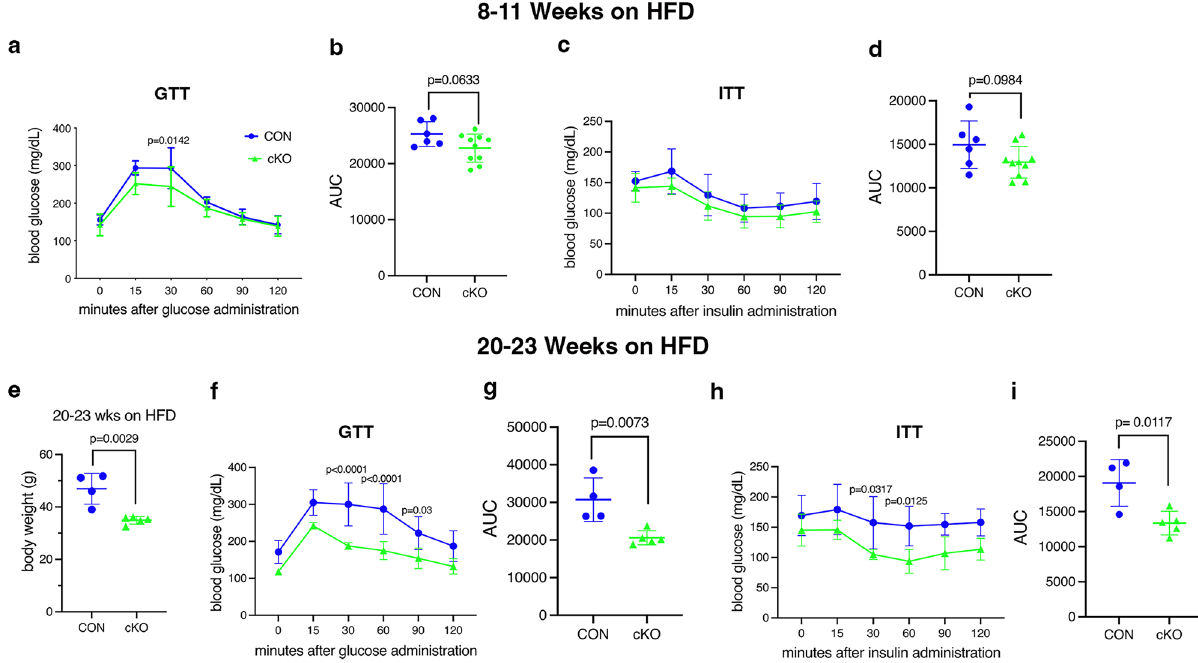
Figure 8. IKKα cKO mice show improved glucose metabolism after HFD. Blood glucose levels were measured during Glucose Tolerance Tests (GTT) and Insulin Tolerance Tests (ITT), which were initiated after a 6 h fast, in female mice. ( a – d ) Tests were performed after 8–11 wks on HFD (n = 6–10). ( a ) GTT, ( b ) area under the curve (AUC) for GTT, ( c ) ITT, and ( d ) AUC for ITT. ( e – i ) Tests were repeated on a subset of mice after 20–23 wks on HFD (n = 4–6). ( e ) body weight at time of GTT, ( f ) GTT, ( g ) AUC for GTT, ( h ) ITT, and ( i ) AUC for ITT. CON = blue, cKO = green. Data are represented as mean ± SD. Repeated measures 2-way ANOVA followed